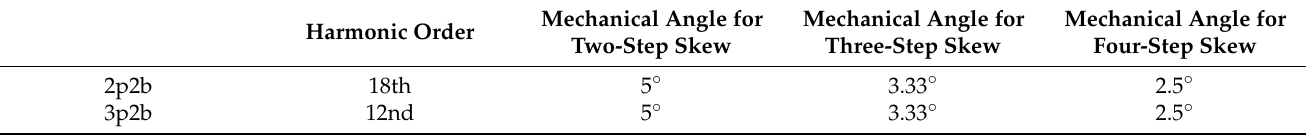
Figure 5. Electromagnetic torque waveform and spectrum of a skewless reference machine: ( a ) torque waveform of four-pole machine with two barriers per pole; ( b ) torque spatial harmonic content of four-pole machine with two barriers per pole; ( c ) torque waveform of six-pole machine with two barriers per pole; ( d ) torque spatial harmonic content of six-pole machine with two barriers per pole. Additionally, 2D and 3D simulation results are compared. Table 2. Skew angle to reduce a specific electromagnetic torque harmonic order by discrete skew. Mechanical Angle for Mechanical Angle for Harmonic Order Two-Step Skew Three-Step Skew